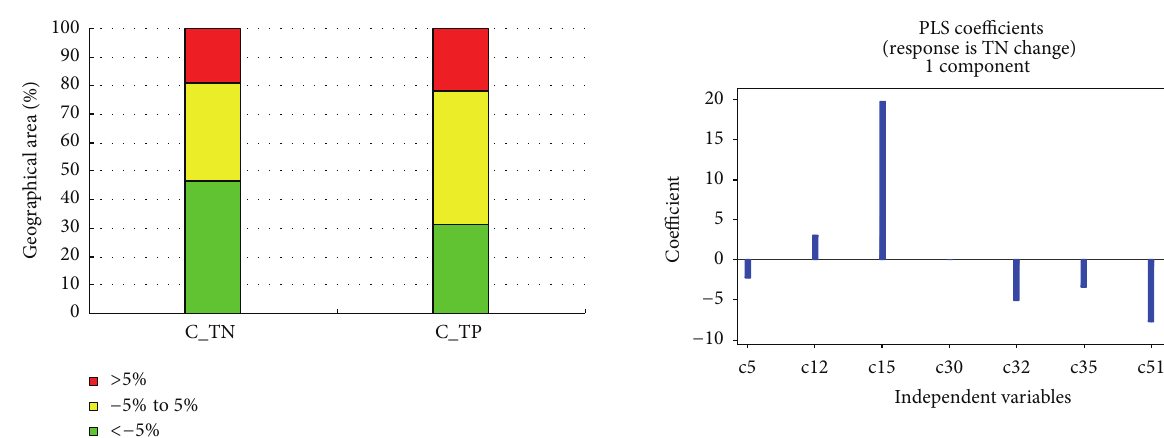
Figure 8: Coefficient map of TN PLRS